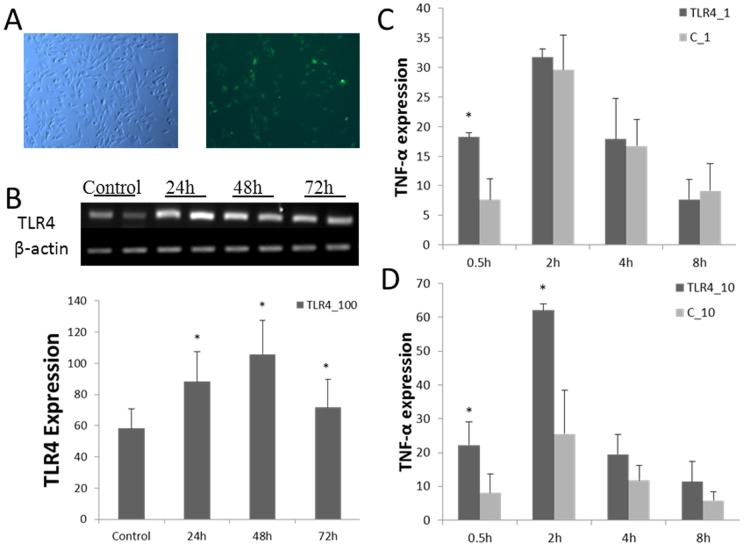
Effects of overexpression of TLR4 in fetal fibroblasts in vitro on the inflammatory reaction.A) Transient transfection of pTLR4-3S vector in the fetal fibroblast cell (100×). B) Show TLR4 overexpressed in fetal fibroblasts by transient transfection. C) and D) TNF-α transcriptional level under LPS (1 ng/mL, 10 ng/mL) stimulation. In the overexpression group, the subjects' immune systems quickly responded to stimulation. In graph: C =  subjects transfected with p3S-LoxP fetal fibroblasts, subjects transfected with TLR4 = pTLR4-3S fetal fibroblasts. Data shown are means ± SE. * Values within the same concentration of LPS with differ significantly across different groups (P<0.05).